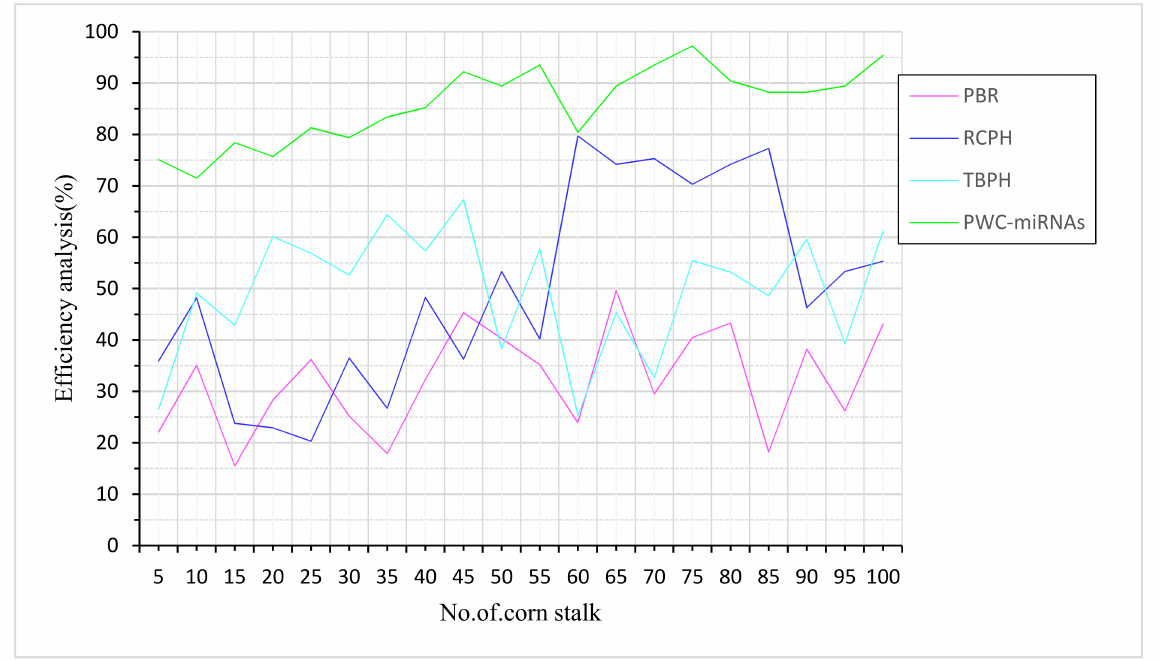
Figure 4. Efficiency analysis of corn